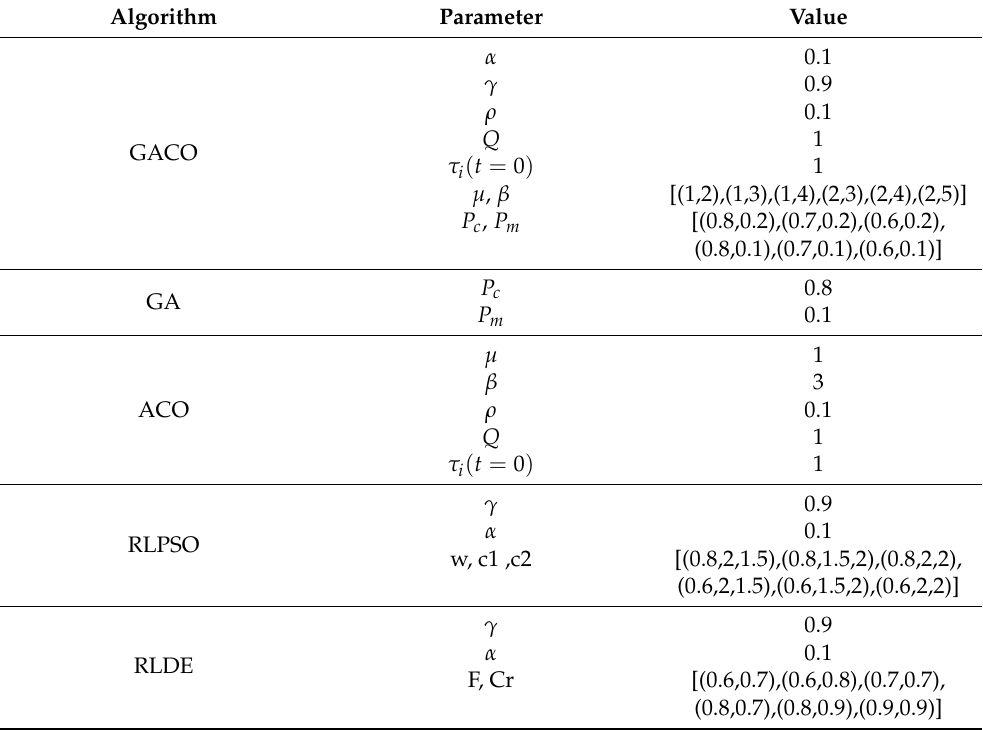
Table 9. Parameter settings.